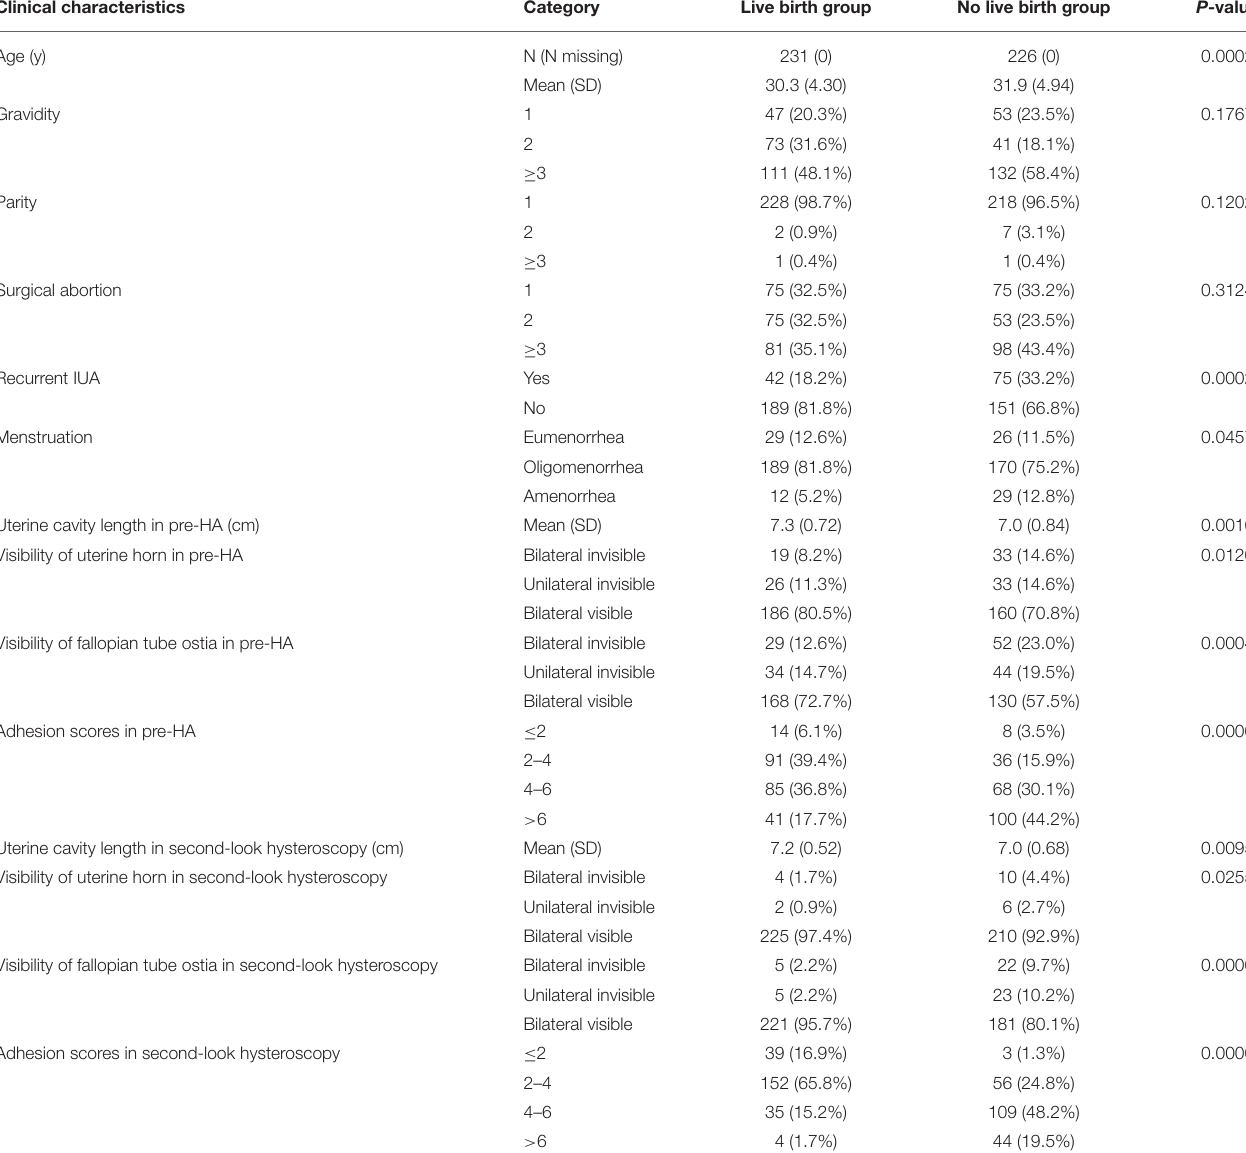
TABLE 1 | Clinical characteristics of the patients with intrauterine